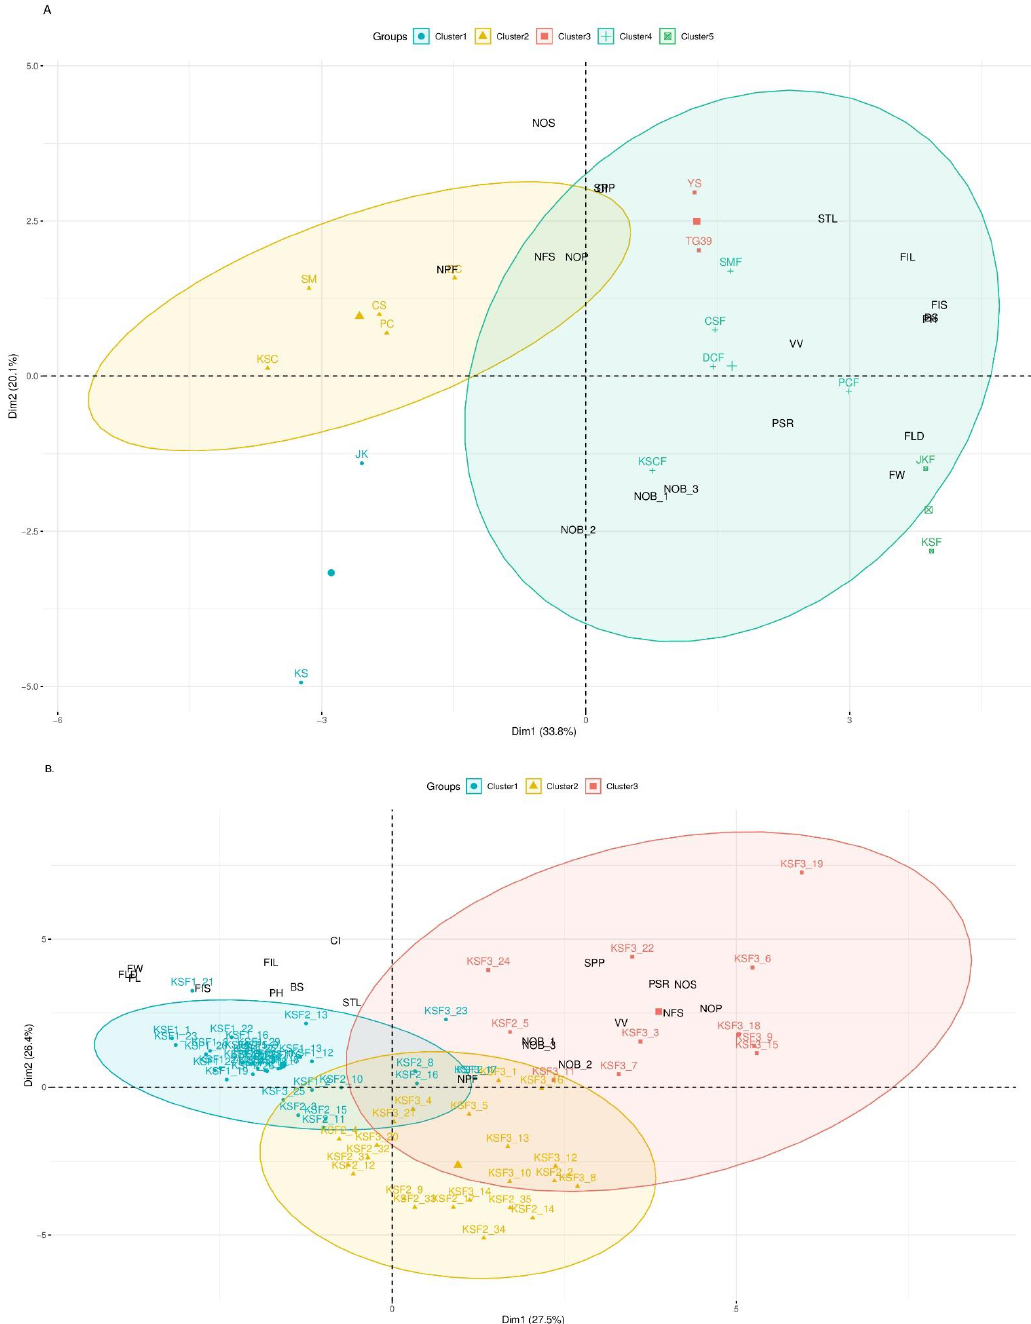
Figure 1. Morphological characteristics represented as variables in these clusters. ( A ) Representa- tion of parental and cross-combination of B. rapa ( ♀ ) x GM B. napus ( ♂ ) (PCC). ( B ) . Representation of B. rapa ssp. rapa ( ♀ ) x GM B. napus ( ♂ ) (KSF 1 to KSF 3